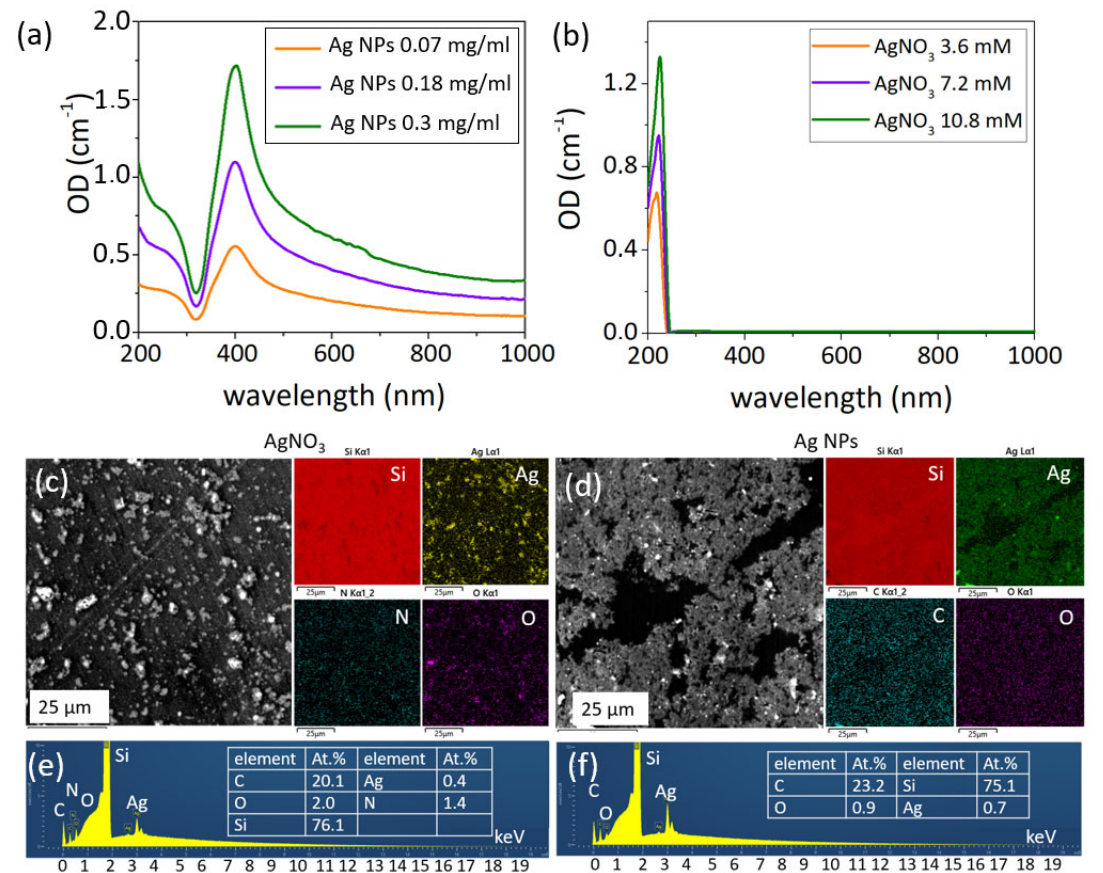
Figure 1. UV − vis spectra of ( a ) Ag NP colloids and ( b ) AgNO 3 solutions with different concentrations; SEM and EDS characterization of AgNO 3 solution ( c , e ) and Ag NP colloid ( d , f ), dried on a Si substrate. Insets on ( e , f ): tables of